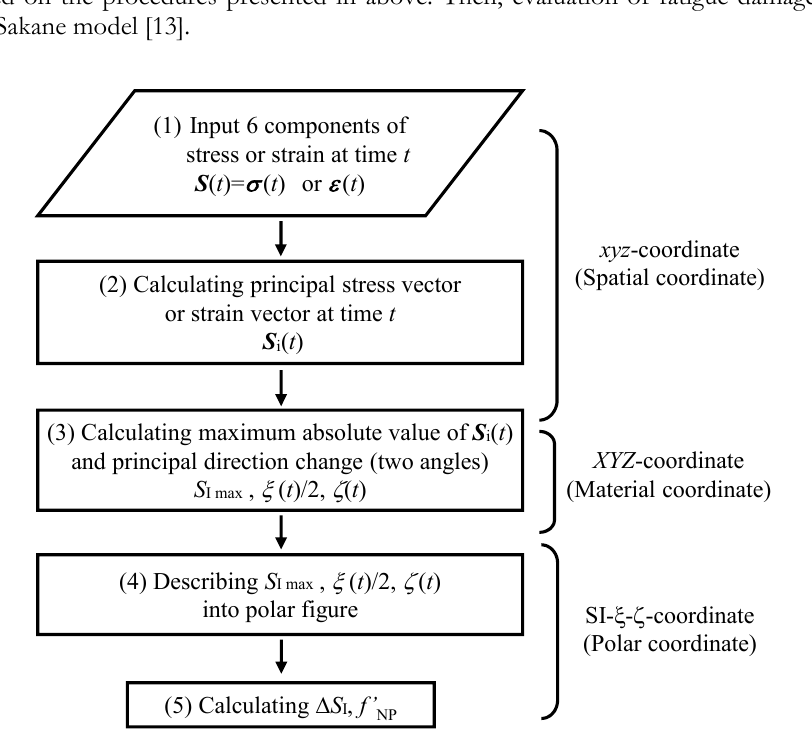
Figure 7: Flow chart of calculation of stress or strain range and